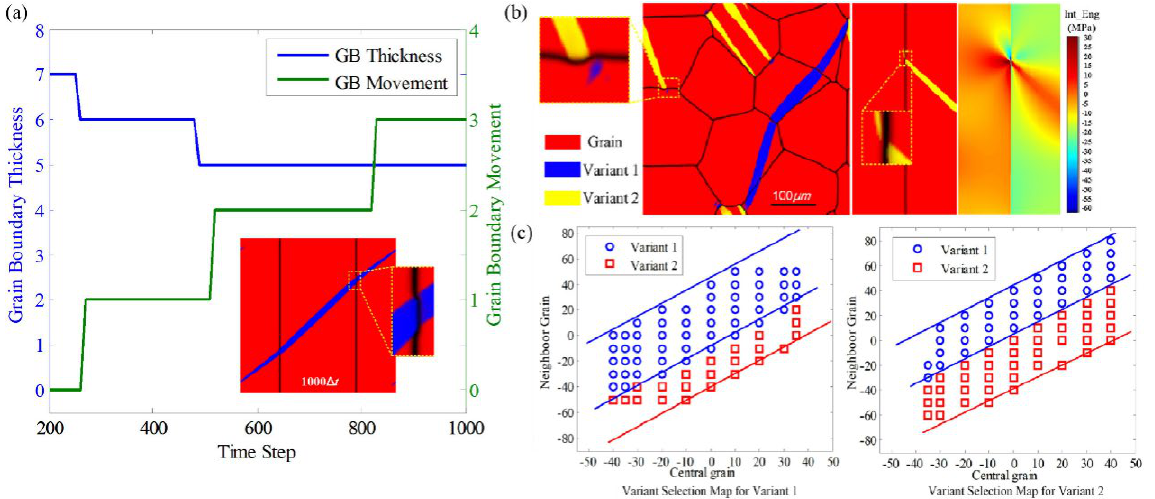
Figure 21. ( a ) the blue line represents the grain boundary thickness and the green line represents the relative movement of the grain boundary, ( b ) the preferred nucleation location in the neighboring grain (left), and distribution of the elastic interaction energy before the nucleation (right), ( c ) variant selection map for each twin variant, under different grain rotation angles: (left) Variant 1, (right) Variant 2 [140].